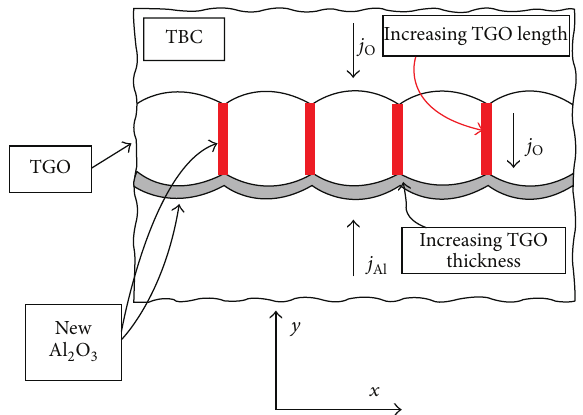
Figure 2: TGO growth mechanism at high